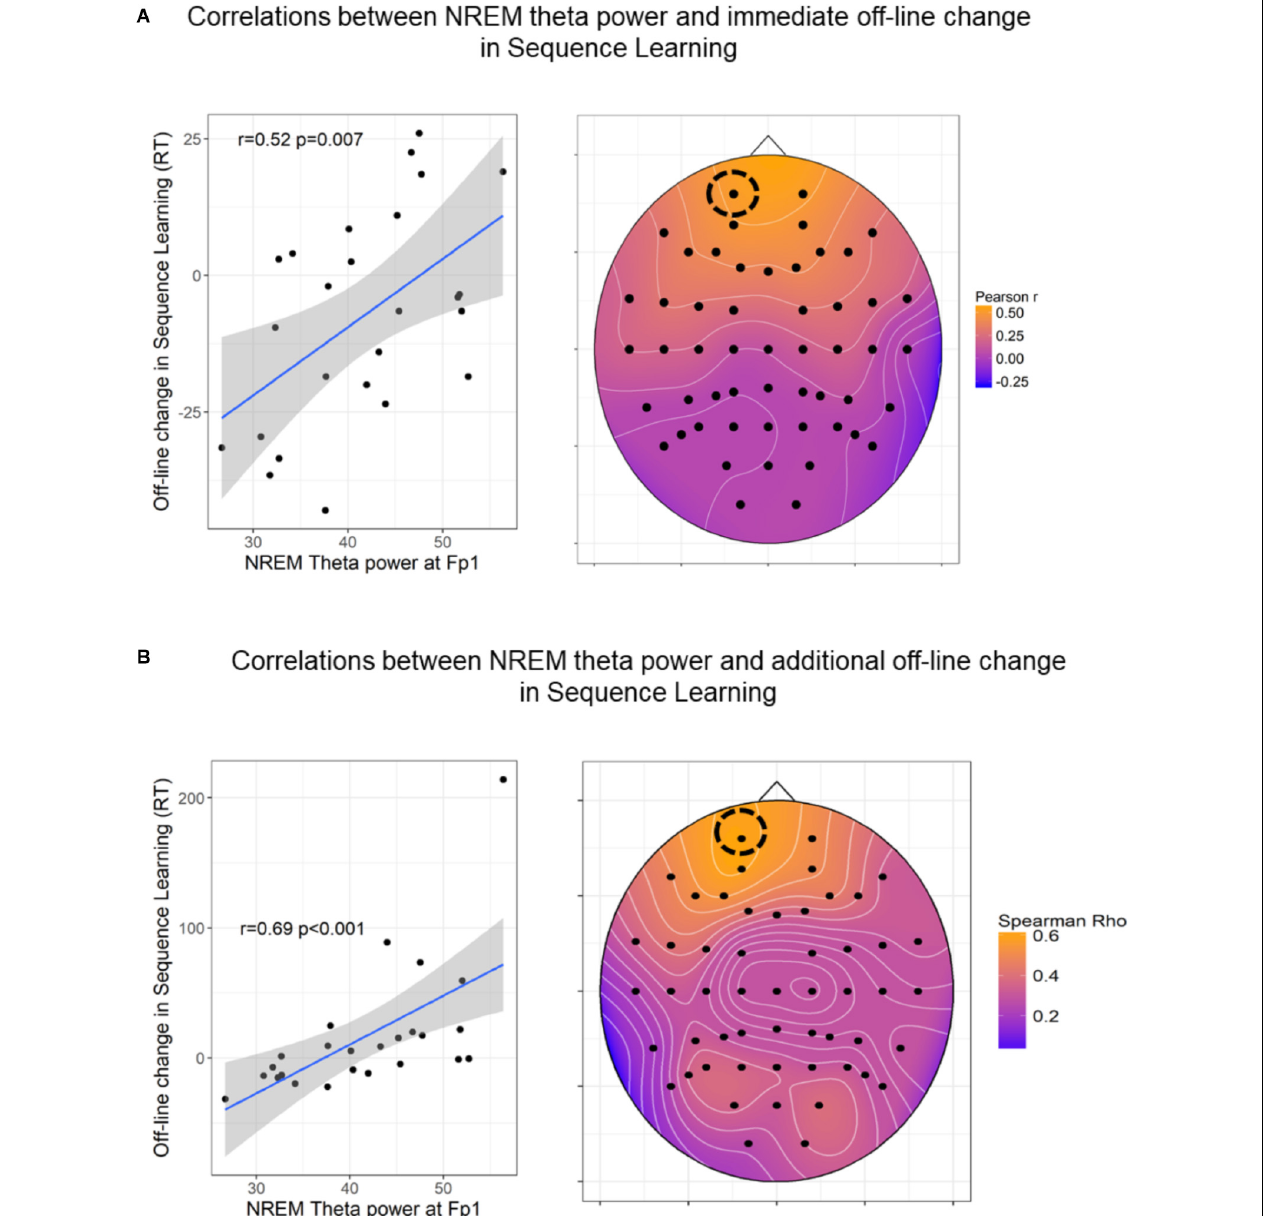
FIGURE 6 | Associations between NREM theta power and off-line changes in Sequence Learning. (A) Pearson correlations between NREM theta band power and immediate (7th vs. 6th epoch) post-sleep changes in Sequence Learning. (B) Spearman Rho correlations coefficients between NREM theta band power and delayed (8th vs. 6th epoch) post-sleep changes in Sequence Learning. The heat plots on the right indicate the magnitude of correlation coefficients, the scatterplots on the left show the association in a prominent (left frontal) electrode site. In case of 6B the correlation coefficient remained unchanged ( r = 0.64, p < 0.001) after the exclusion of the outlier. The figures show uncorrected p -values (before FDR correction). For the immediate off-line changes, only Fp1, Fp2, AF3, AF4 locations remained significant after FDR correction. For the additional off-line changes, frontal channels Fp1, Fpz, Fp2, AF3, AF4, F7, F5, F3, F1, Fz, F2, F4, F6, F8 as well as FC4, FC5, CP5, and P5 locations remained significant after FDR